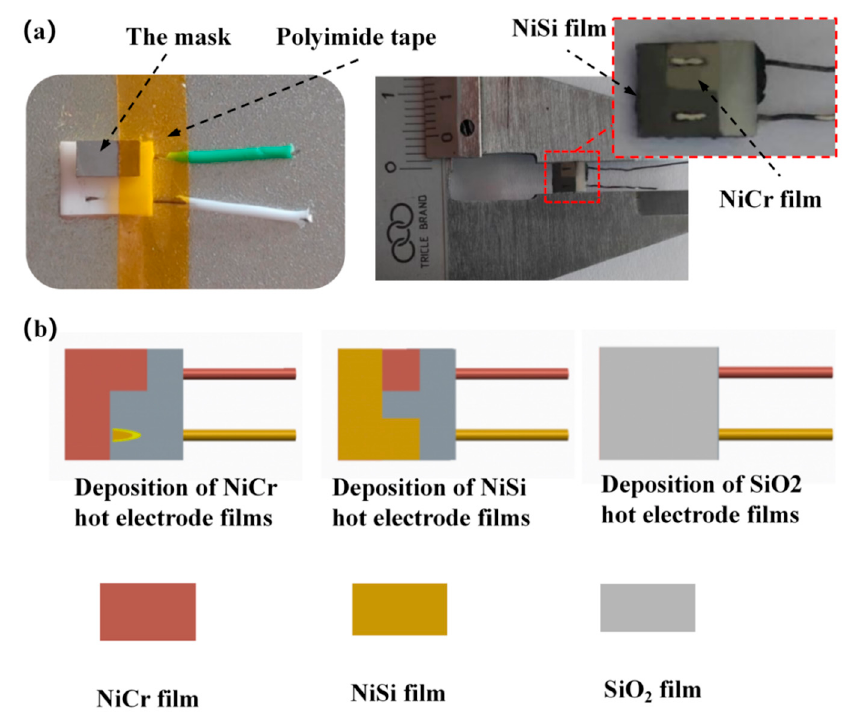
Figure 6. ( a ) Sensor mask. ( b ) Sensor fabrication process.